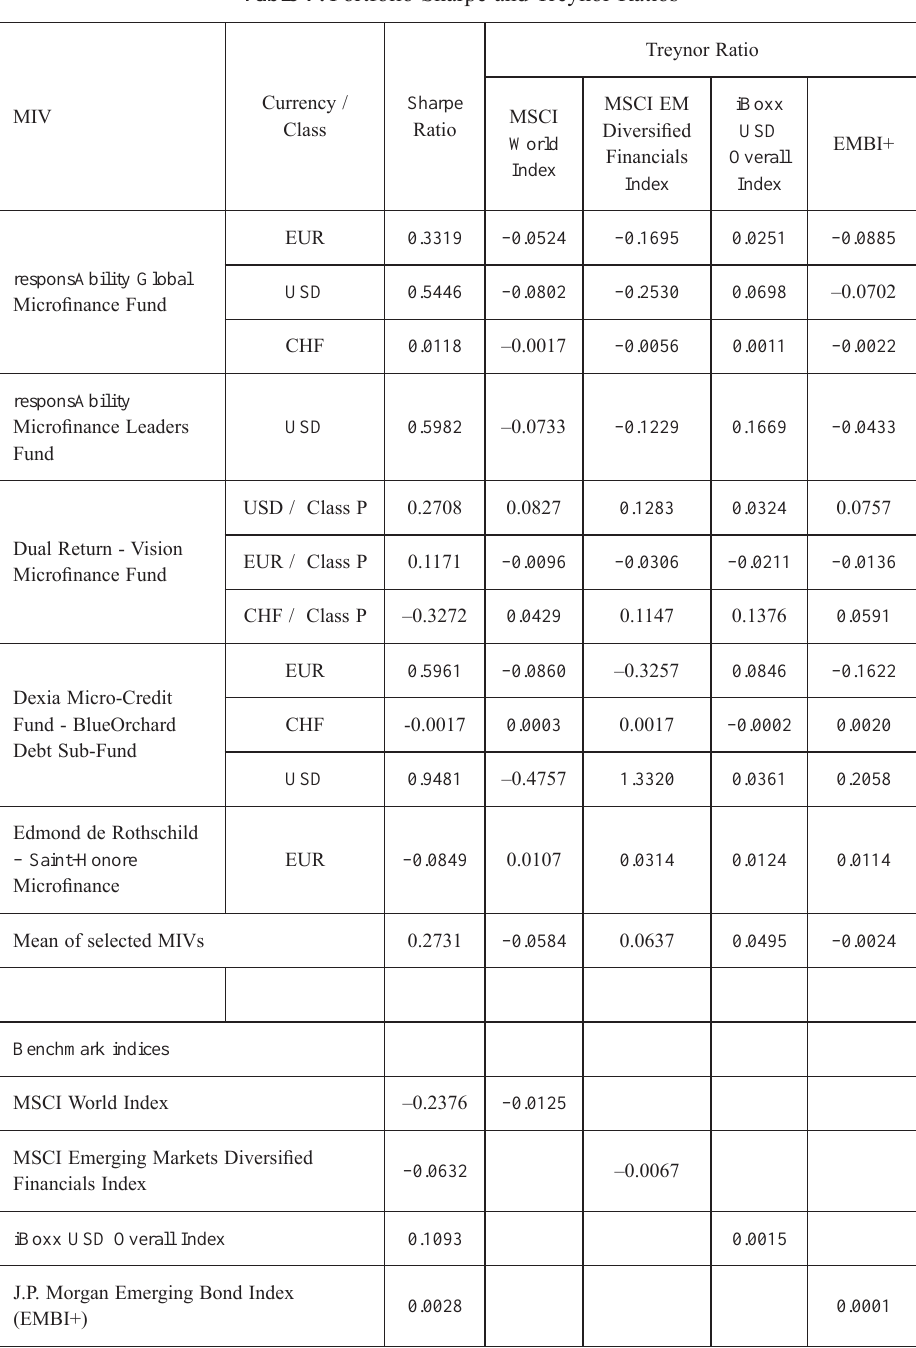
Table 7. Portfolio Sharpe and Treynor